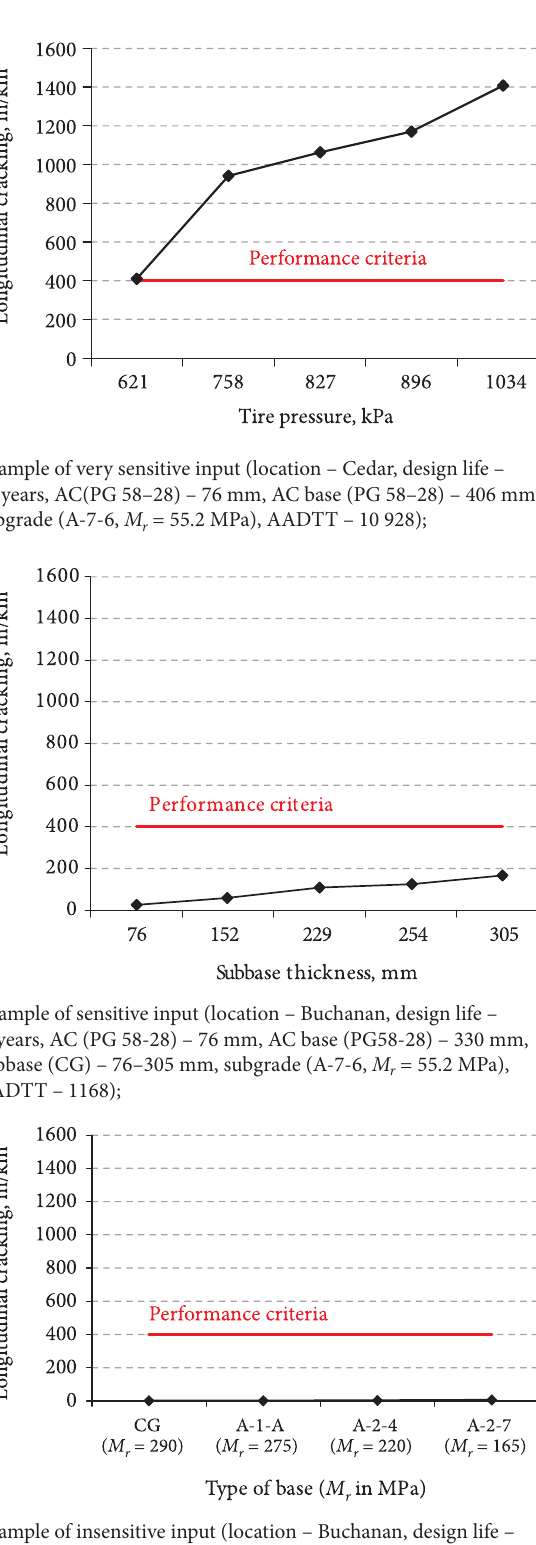
fig. 2. Interactive effect of two design inputs on flexible